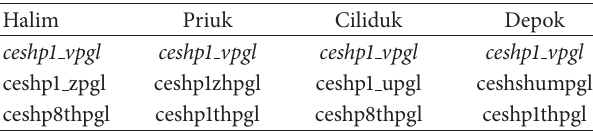
Table 1: CanESM2 predictors used in screening process. Table 2: List of CanESM2 predictors selected for